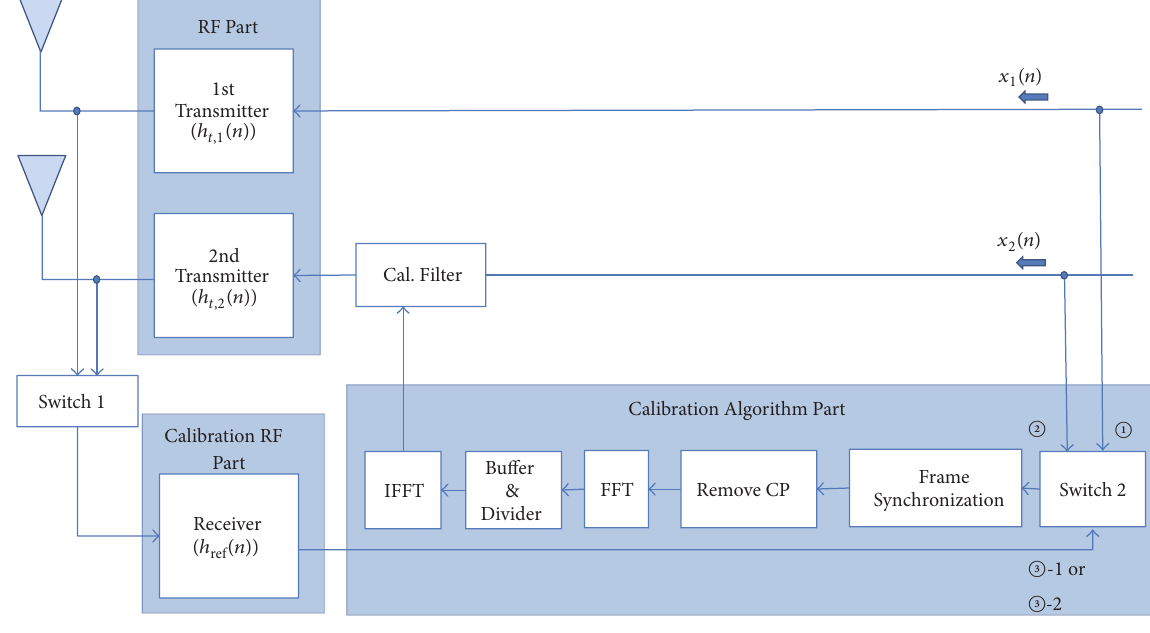
Figure 5: Diagram of the proposed downlink calibration.